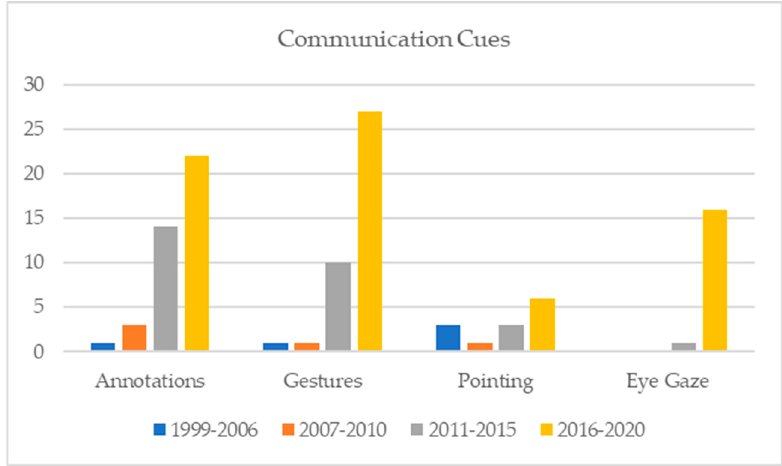
Figure 7. Communication cues occurrences for the period 1999–2020.